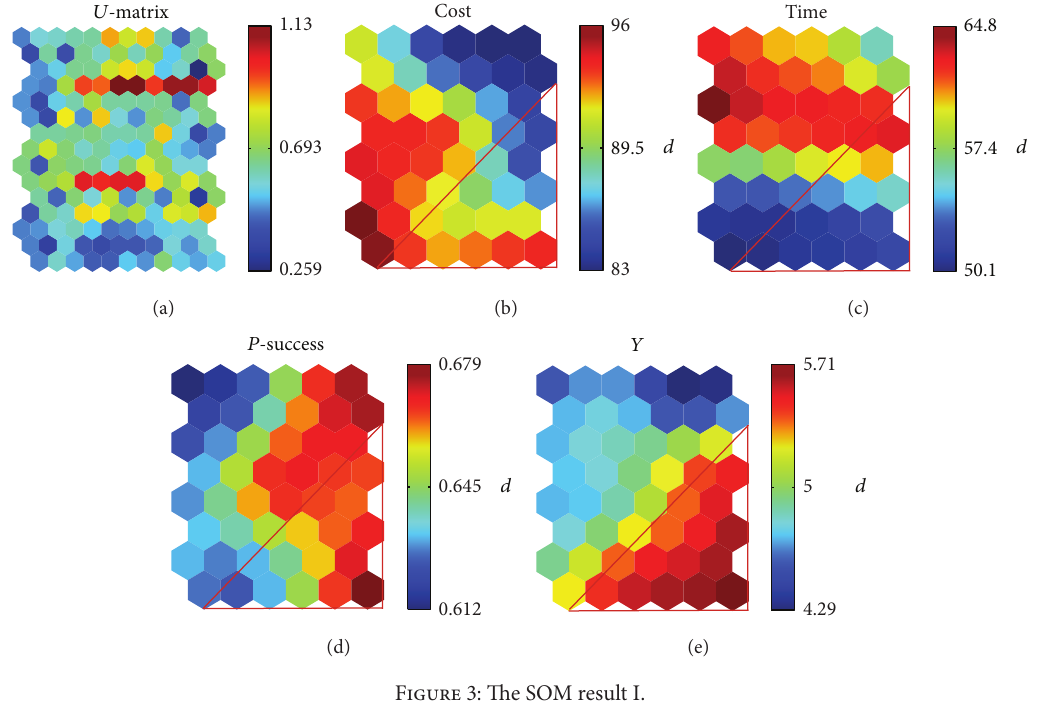
Figure 3: The SOM result I.